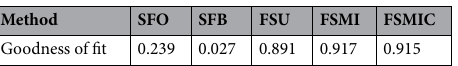
Table 5. Goodness of fit of five interaction methods.